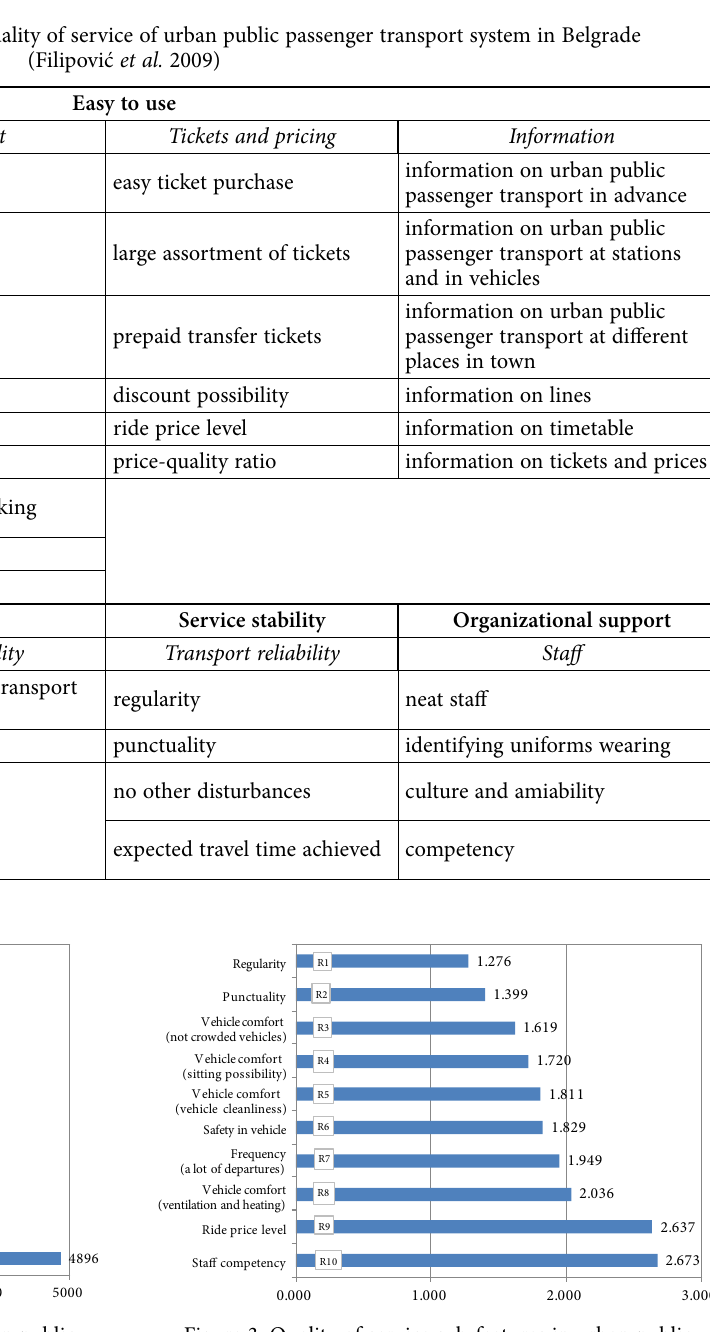
Figure 2. Ten most important sub-features of urban public passenger transport quality of service in Belgrade based